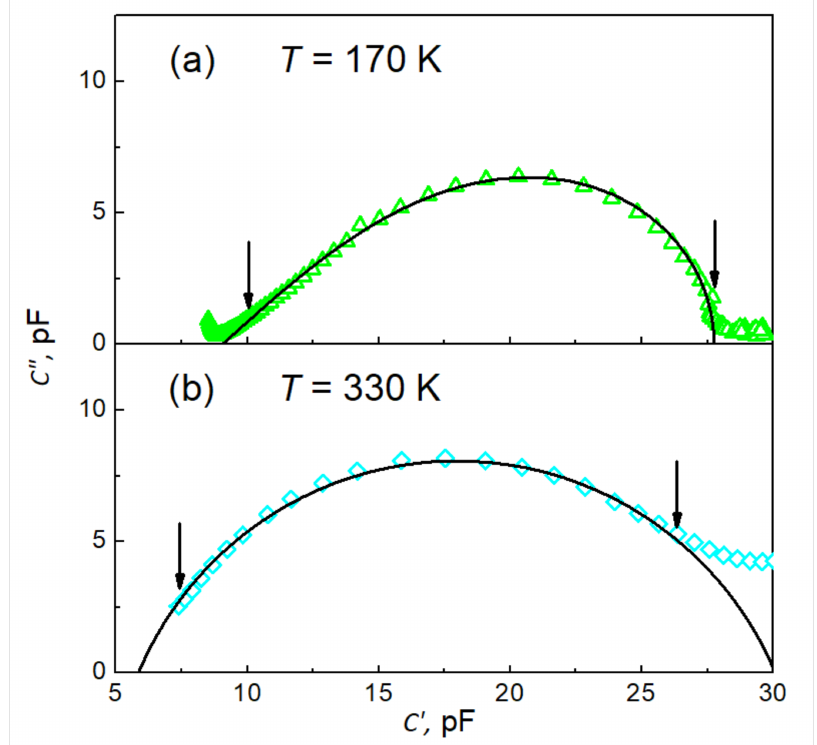
Figure 7. Cole–Cole-type plots C (cid:48)(cid:48) vs. C (cid:48) of experimental data (open symbols) and their best fits (black solid lines) ( a ) to Equation (5) with C ∞ = 90.52(89) pF, ∆ C = 18.69(10) pF, τ CD = 25.84(56) ms, and β = 0.4674(74) and ( b ) to Equation (6) with C ∞ = 5.86(28) pF, ∆ C = 24.22(43) pF, τ CC = 2.83(40) ms, and ¦ α = 0.7449(26). The vertical arrows indicate the range of data used for the